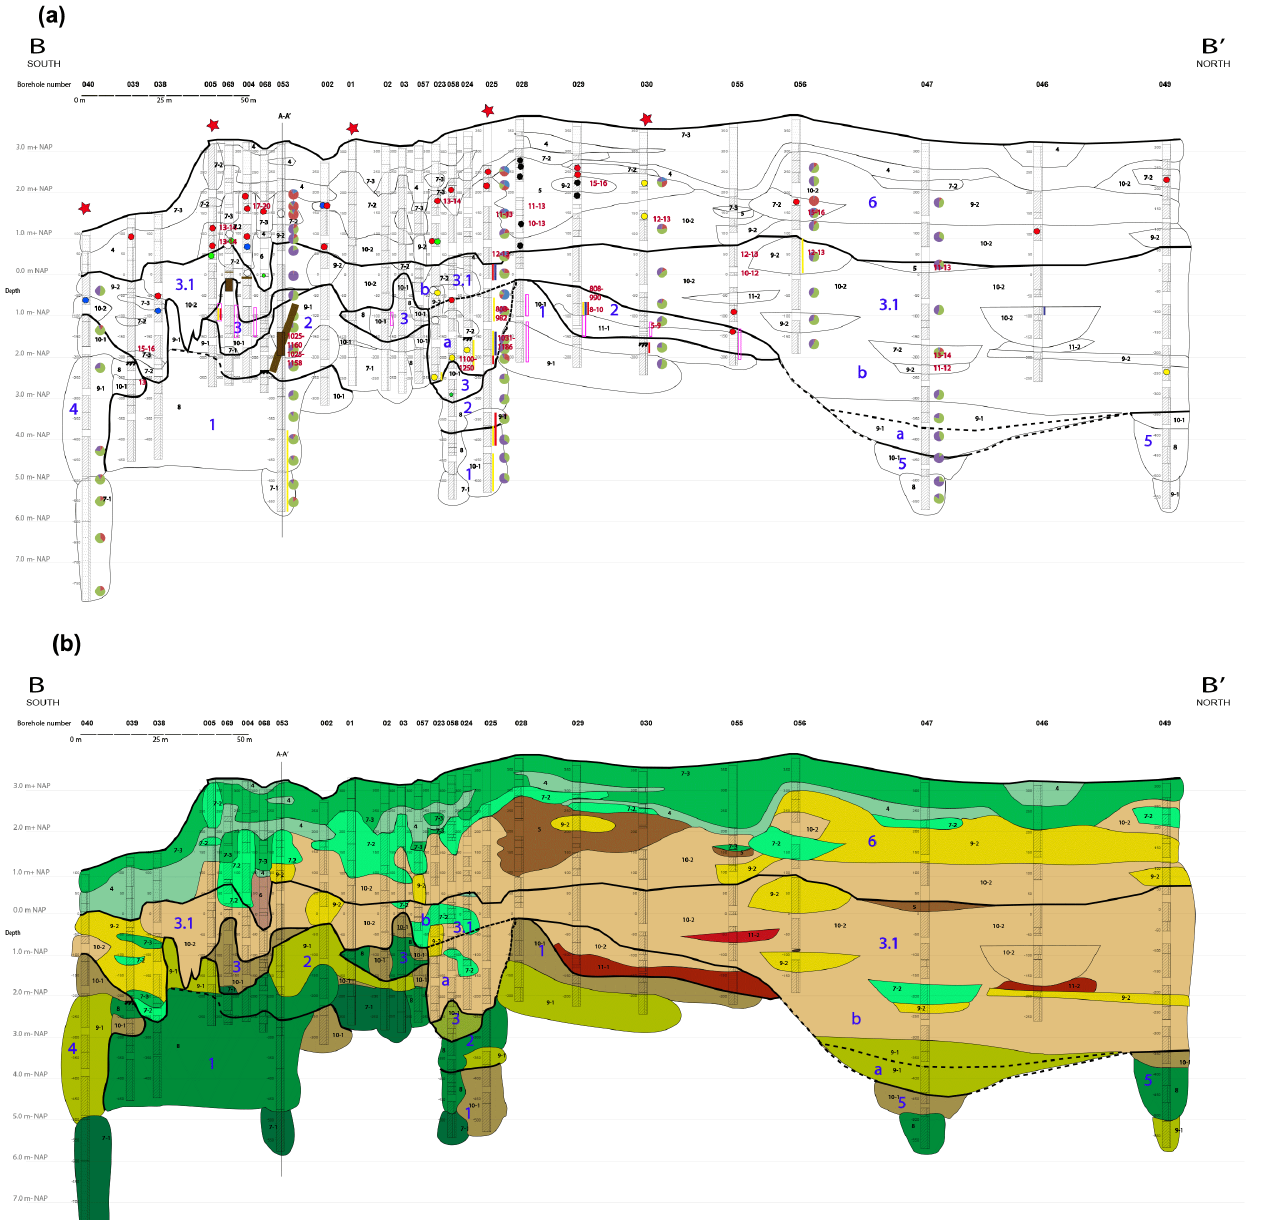
Figure 6. (a) North–south (B–B (cid:48) ) cross-section of mound of Vlaardingen Stadshart and its natural subsurface with data sheet. (b) North– south (B–B (cid:48) ) cross-section of mound of Vlaardingen Stadshart and its natural subsurface.